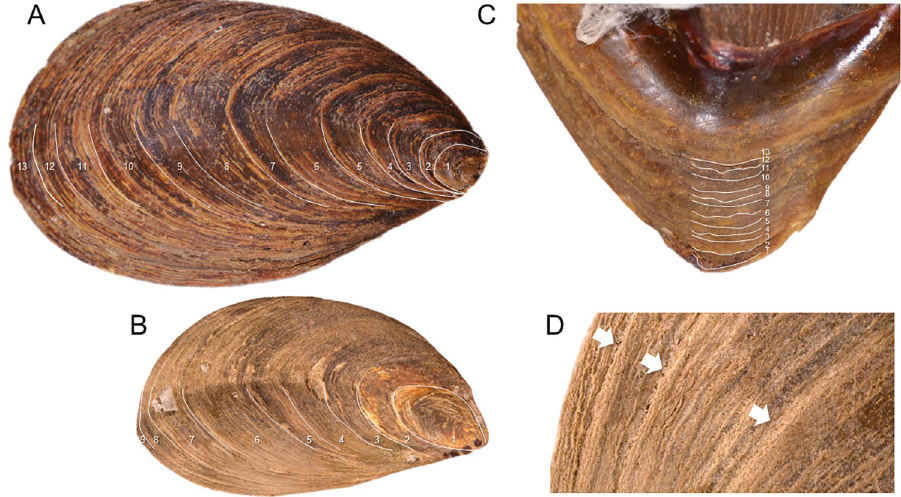
Fig 3. Counts of opercular striae and adventitious layers. Opercula showing annual striae (A, B, D) on external surface and interior adventitious layers (E). A, C, D. Specimen Tg-A (BMSM 119422) from the Dry Tortugas, Florida Keys. B. Specimen Tg-C from Cape Romano, Florida. White lines indicate annual striae and adventitious layers. Arrows mark sharp ledges of annual striae on the external